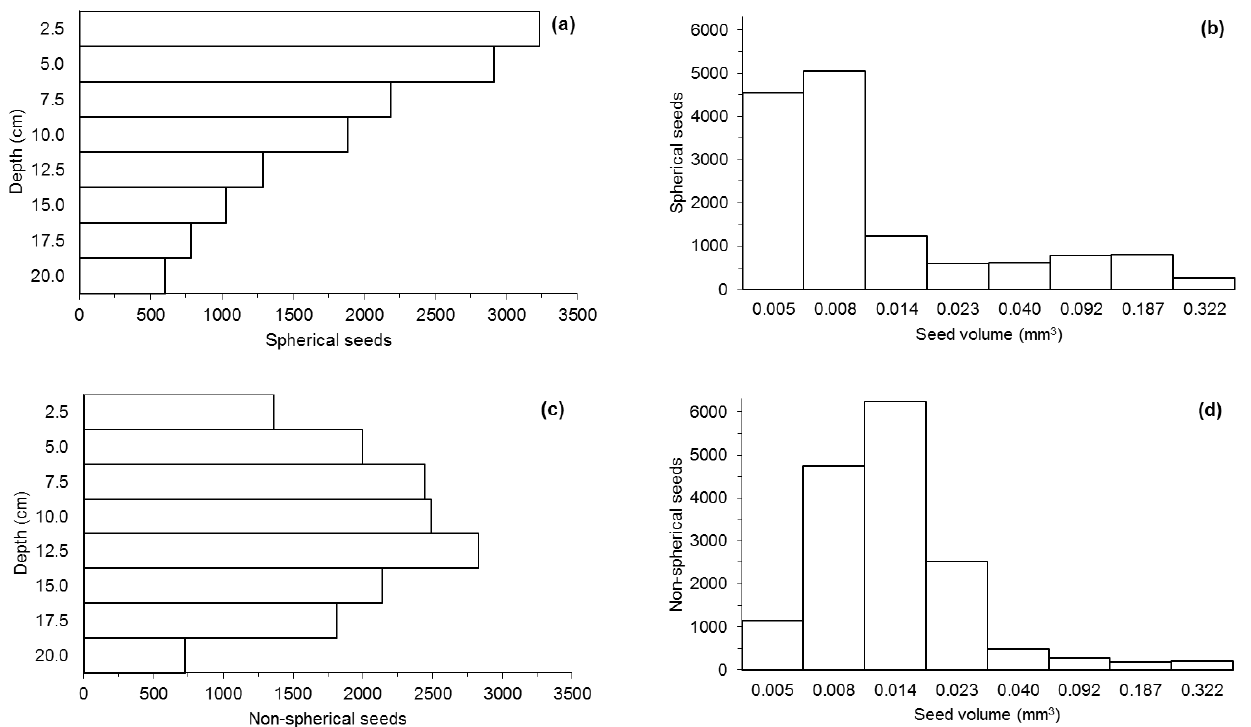
Figure 1. Number of spherical ( a , b ) and non-spherical ( c , d ) seeds in relation to soil depth, all sizes combined ( a , c ), and to seed volume, all depths combined ( b , d ). The volume of seeds refers to the highest value in each interval resulting from the sequential sieving.